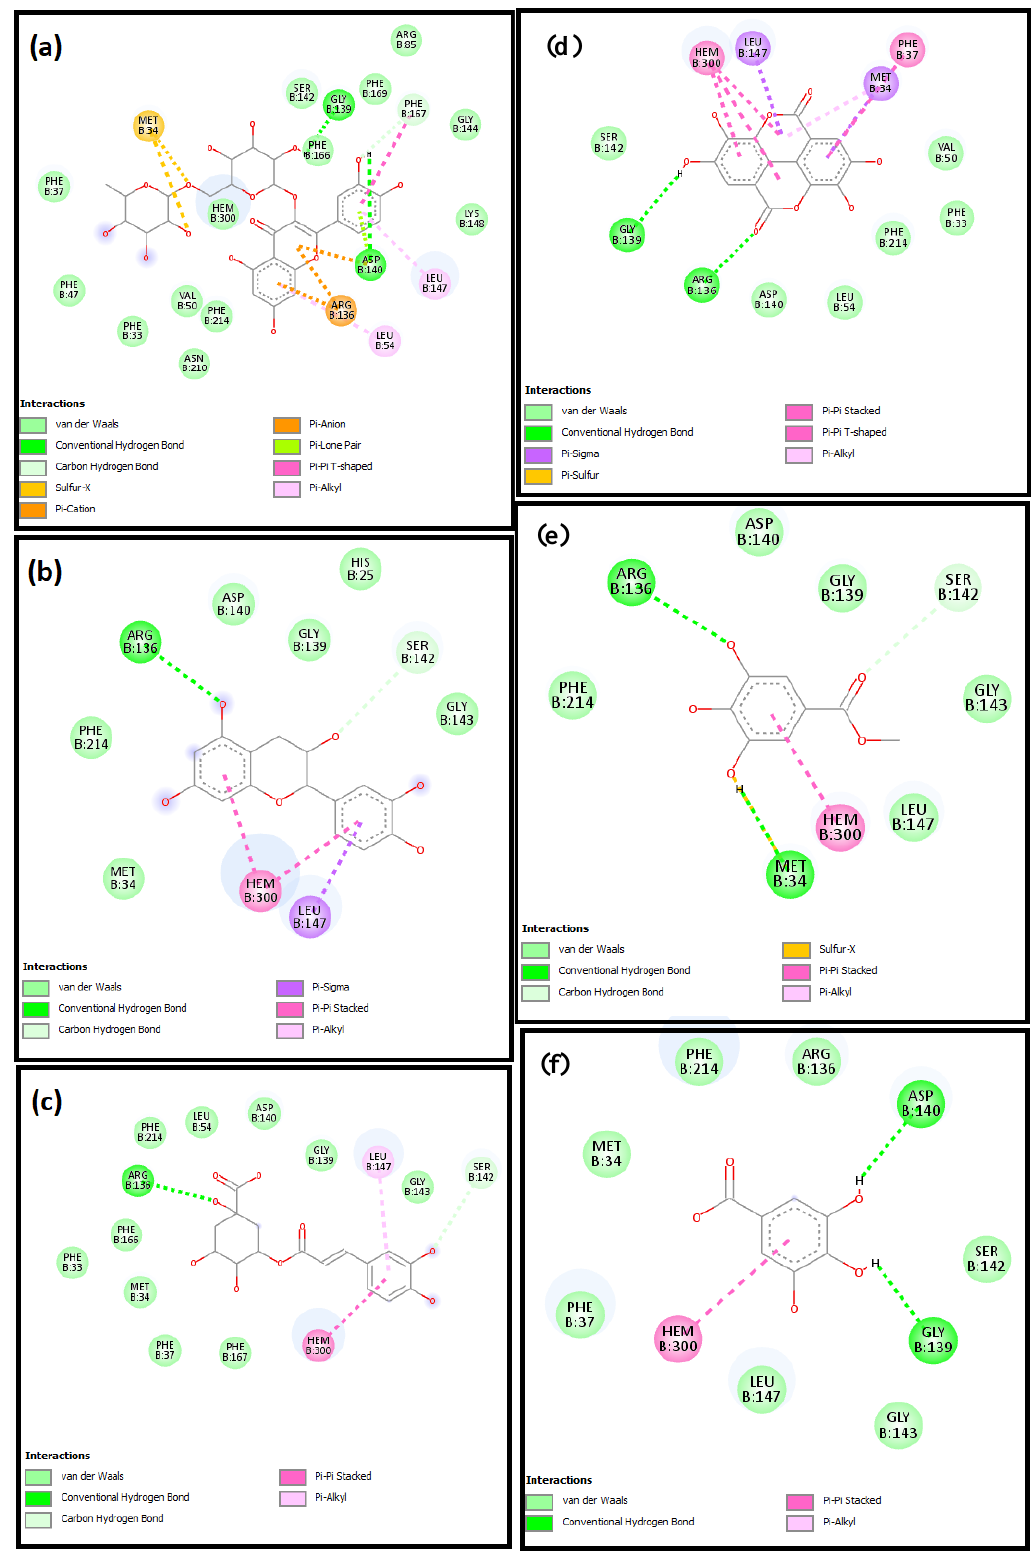
Figure 13. The 2D schematic interactions of docked ( a ) RUT, ( b ) CAT, ( c ) CHL, ( d ) ELL, ( e ) GAT, and ( f ) CAT with human HO-1 (Code: 3CZY).